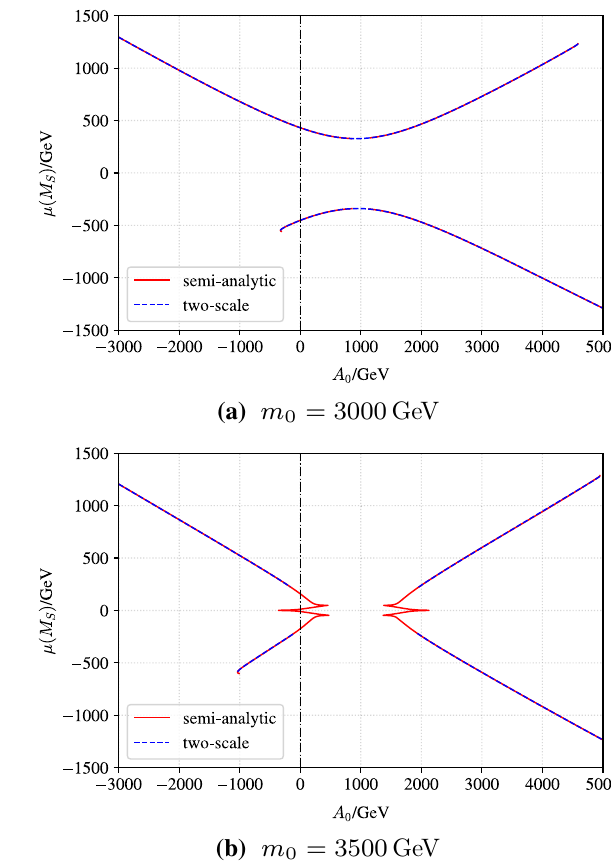
Fig. 10 The relation between A 0 and μ obtained with the TSS (blue) and the SAS3 (red) for two different values of m 0 . The dash- dotted lines (black) give the points where A 0 = 0. The intersection points of the colored and the vertical black lines mark the same solutions as the ones shown in